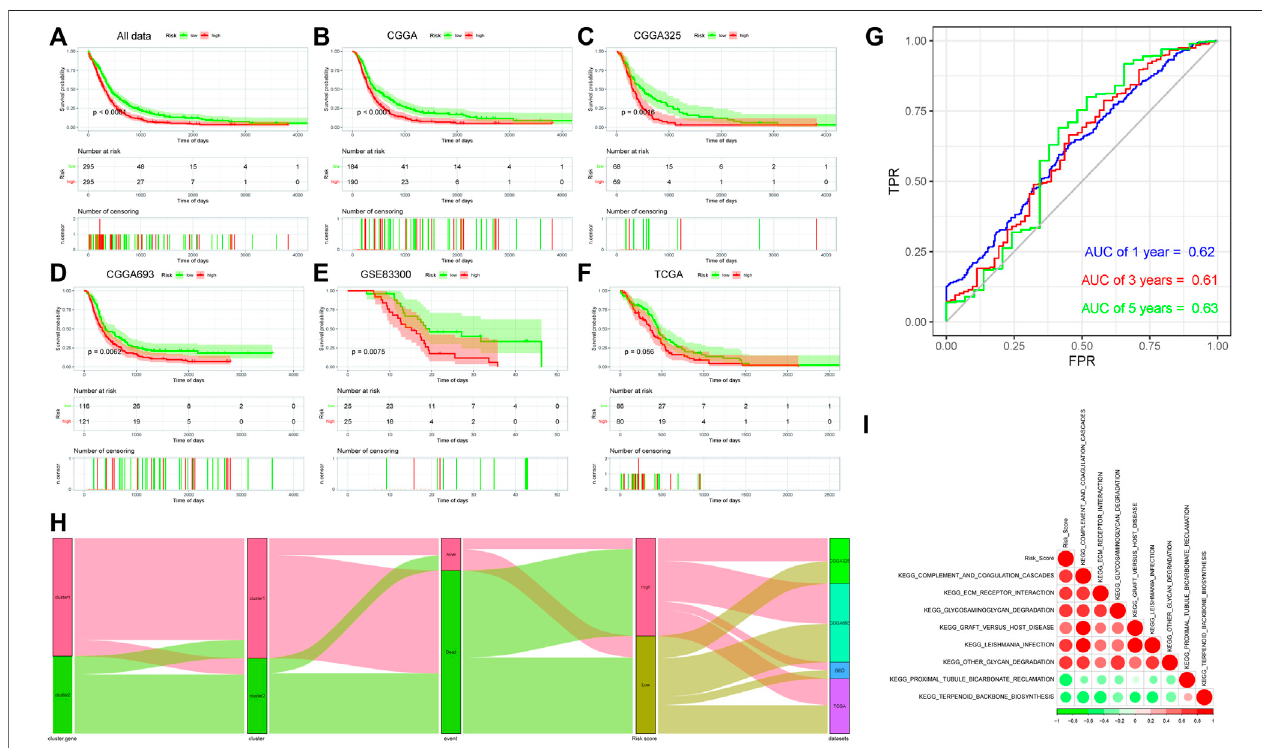
FIGURE 4 | (A – F) : Kaplan – Meier survival analysis results of risk score subgroups in different data cohorts. The abscissa axis represents survival time, and the ordinate axis represents survival probability. (A) Kaplan – Meier survival analysis results of risk score subgroups in the comprehensive data cohort. (B) Kaplan – Meier survival analysis results of risk score subgroups in the CGGA data cohort. (C) Kaplan – Meier survival analysis results of risk score subgroups in the CGGA325 data cohort. (D) Kaplan – Meier survival analysis results of risk score subgroups in the CGGA693 data cohort. (E) Kaplan – Meier survival analysis results of risk score subgroups in the GSE83300 data cohort. (F) Kaplan – Meier survival analysis results of risk score subgroups in the TCGA data cohort. (G) Time-based ROC curve: the abscissa axis represents FPR (false-positive rate), and the ordinate axis represents TPR (true-positive rate). (H) Sankey diagram based on the distribution of characteristics. (I) Correlation analyses between the risk score and differential enrichment pathway